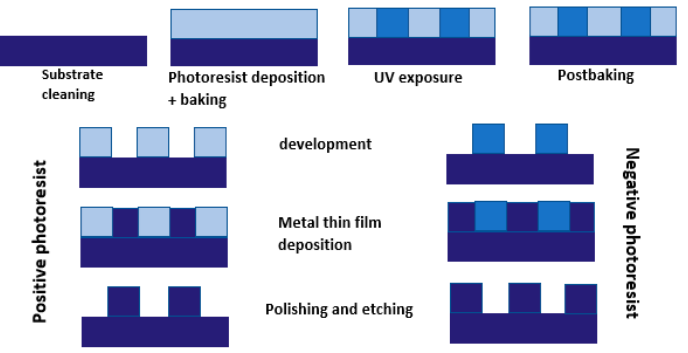
Figure 7. Basics steps of UV photolithography for micro-feature fabrication [101] (after Museau 2007 [101]).